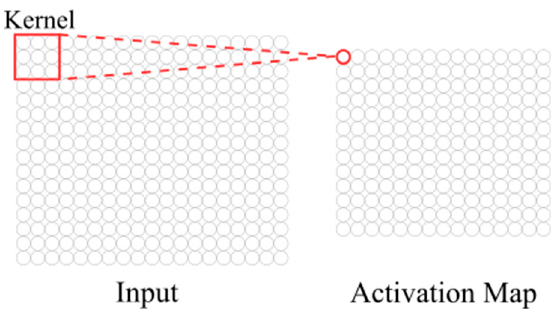
Figure 5. Graphic example of convolution function.